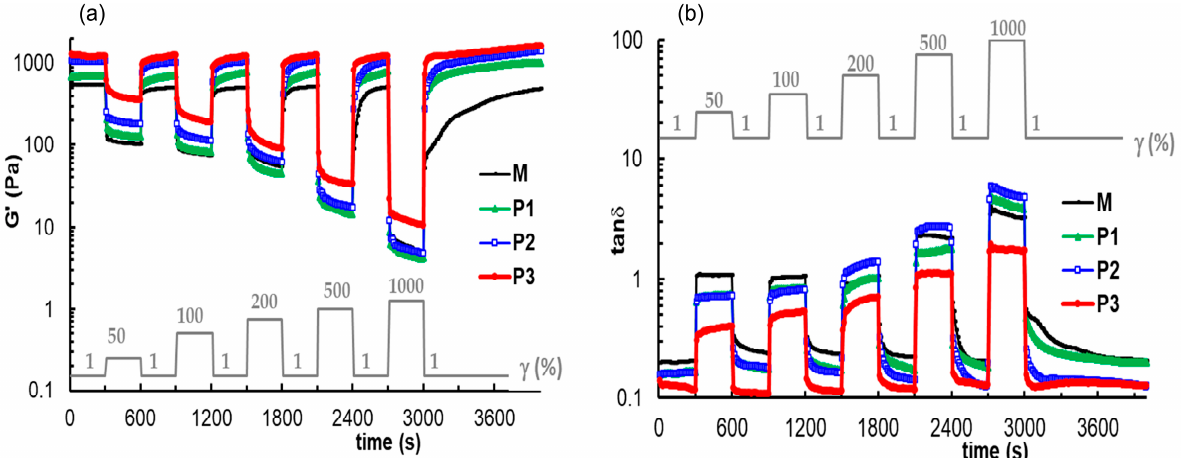
Figure 8. The elastic modulus ( a ) and loss tangent ( b ) during the experiments at low and high suc- cessive step strains applied every 300 s. successive step strains applied every 300